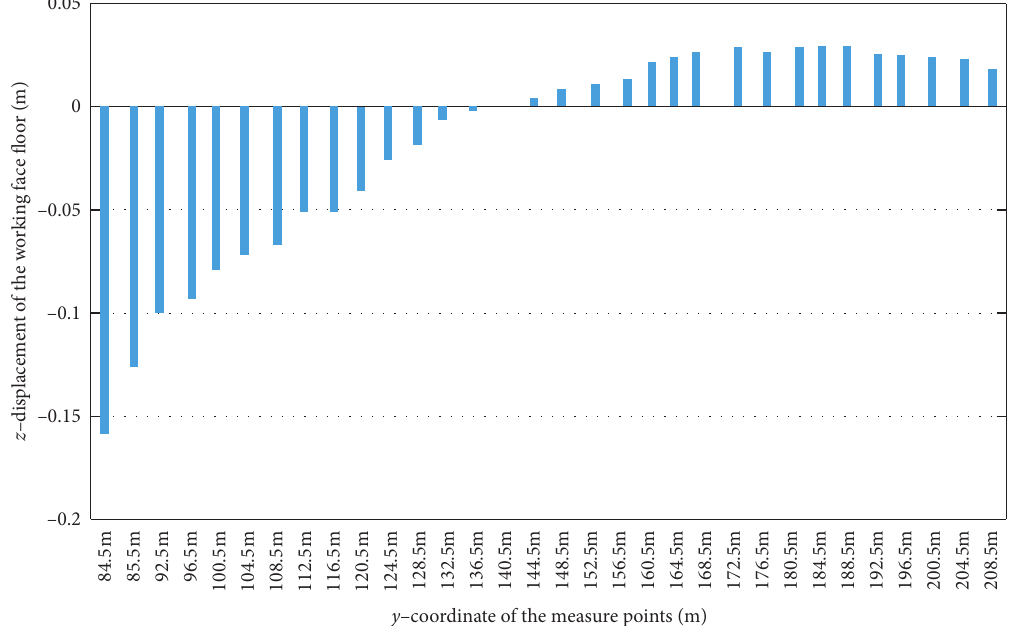
Figure 14: z -displacement of the face floor after backfilling.